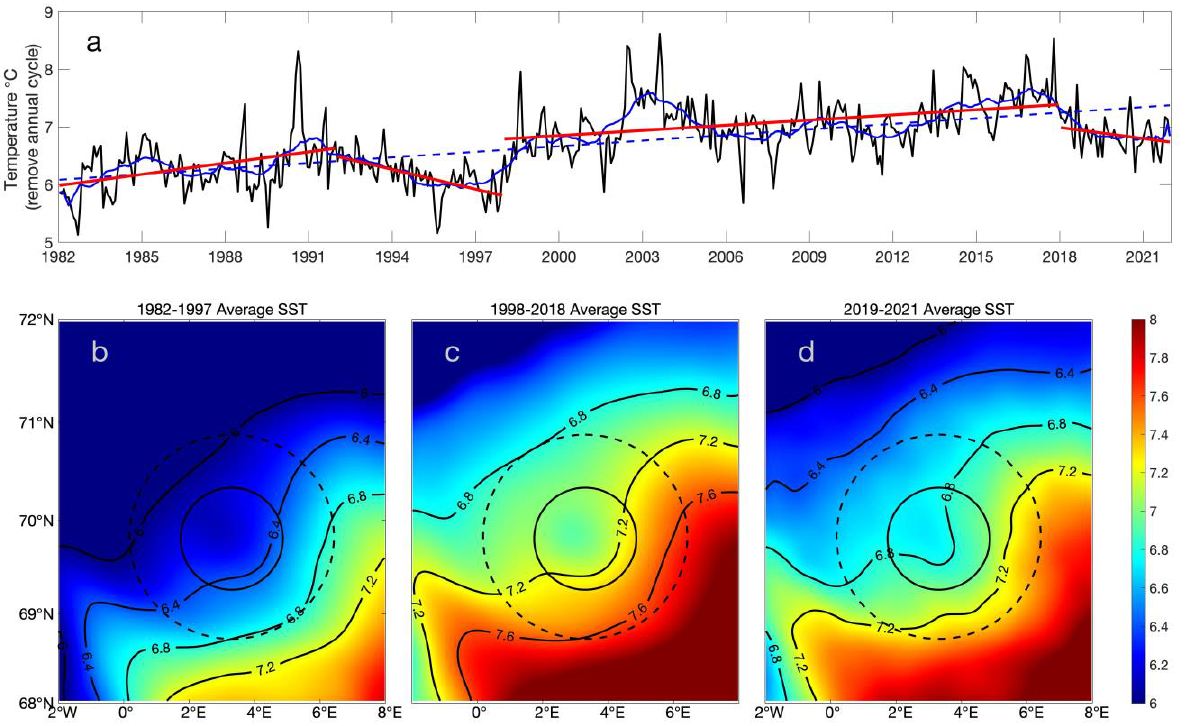
Figure 9. Trend and variations in the SST throughout the CLV sea area. ( a ) Removed annual cycle SST series (the black thick line) and 24-month moving average SST time series (the blue line). A long trend throughout the period of 01-01-1982 to 31-12-2021 (black dashed line) and significantly segmental trends (red lines) can be seen. Spatially averaged SST can be seen throughout the periods of ( b ) 1982–1997, ( c ) 1998–2018, and ( d ) 2019–2021.